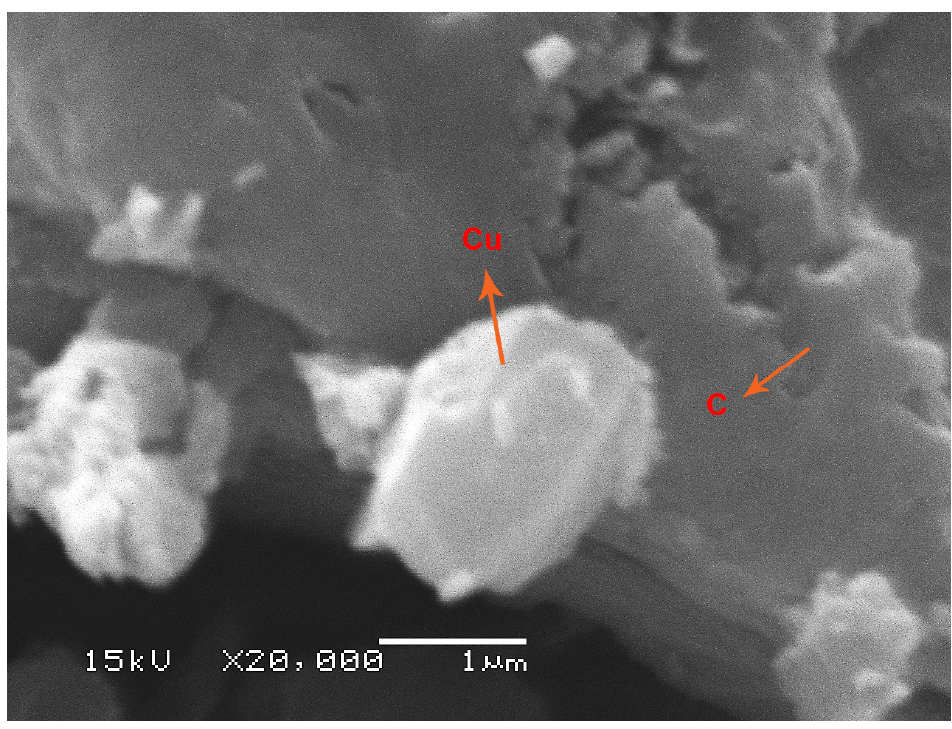
Figure 5. SEM pictures of fresh 5U10Cu at 20,000 times magnification.